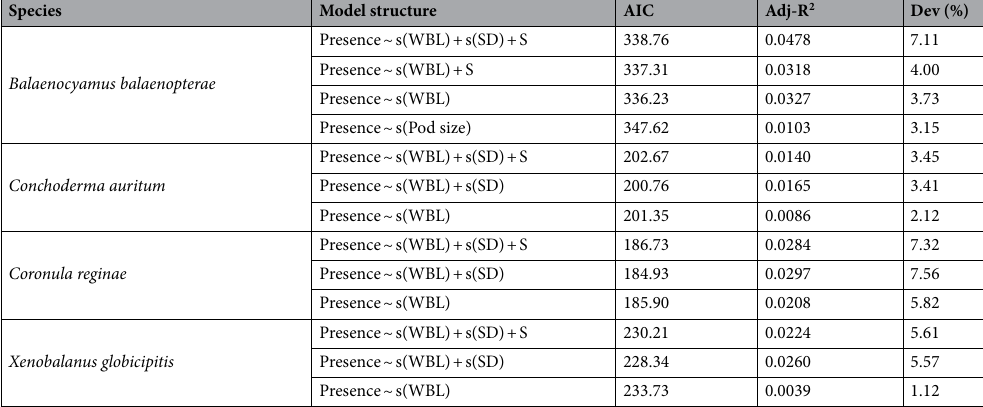
Table 4. Stepwise selection of binomial models based on the lowest value of Akaike Information Criterion (AIC). The presence (or absence) of the four more prevalent epibiotic species on Antarctic minke whales, Balaenoptera bonaerensis , is investigated with three predictors: WBL whale length, SD sampling date, and S sex of the whale. The effect of pod size was tested only for Balaenocyamus balaenopterae (see main text). Other values for model evaluation include the R 2 -adjusted coefficient and the percentage of deviance explained.